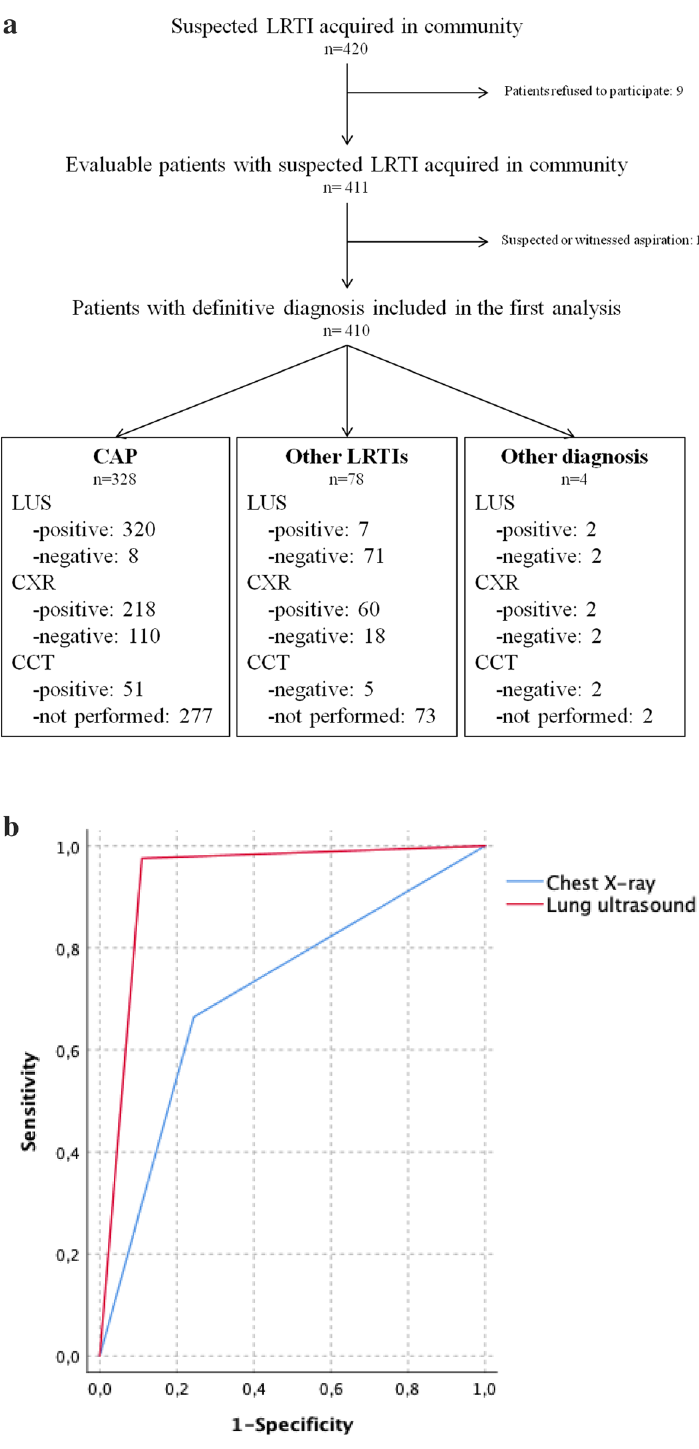
Figure 1. ( a ) Flow chart of participant enrollment and results of chest X-ray and lung ultrasound according to the definitive diagnosis made by physician in charge at the end of clinical work-up. List of abbreviations: LRTI lower respiratory tract infection, CAP community-acquired pneumonia, LUS lung ultrasound, CXR chest X-ray, CCT computed chest tomography. ( b ) Receiver operating characteristic curves for diagnosing pneumonia among patients with suspected lower respiratory tract infection by lung ultrasound and chest X-ray. Areas under the receiver operating characteristic curves = lung ultrasound: 0.93 (95% CI, 0.89–0.97), chest X-ray: 0.71 (95% CI,